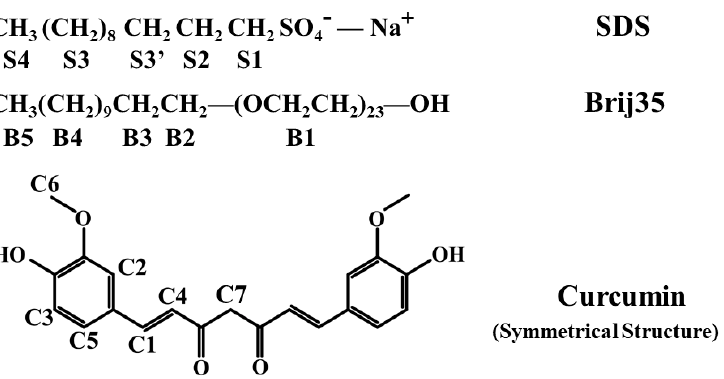
Scheme 1. Chemical structures and proton numbering of SDS, Brij35 and curcumin.